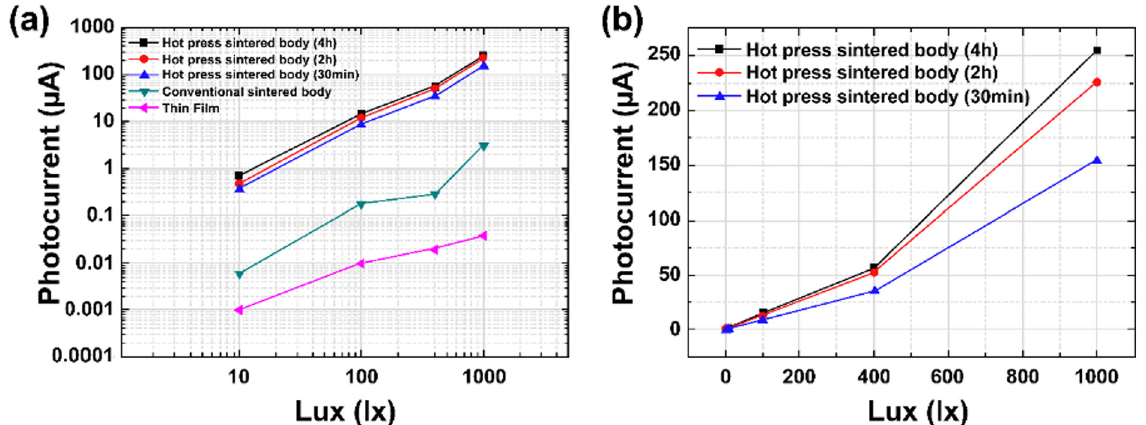
Figure 4. ( a ) Photocurrent of (Sr 0.99 Eu 0.01 )Al 2 O 4 samples with increasing light intensity. ( b ) Photocurrent of the samples with various soaking times.